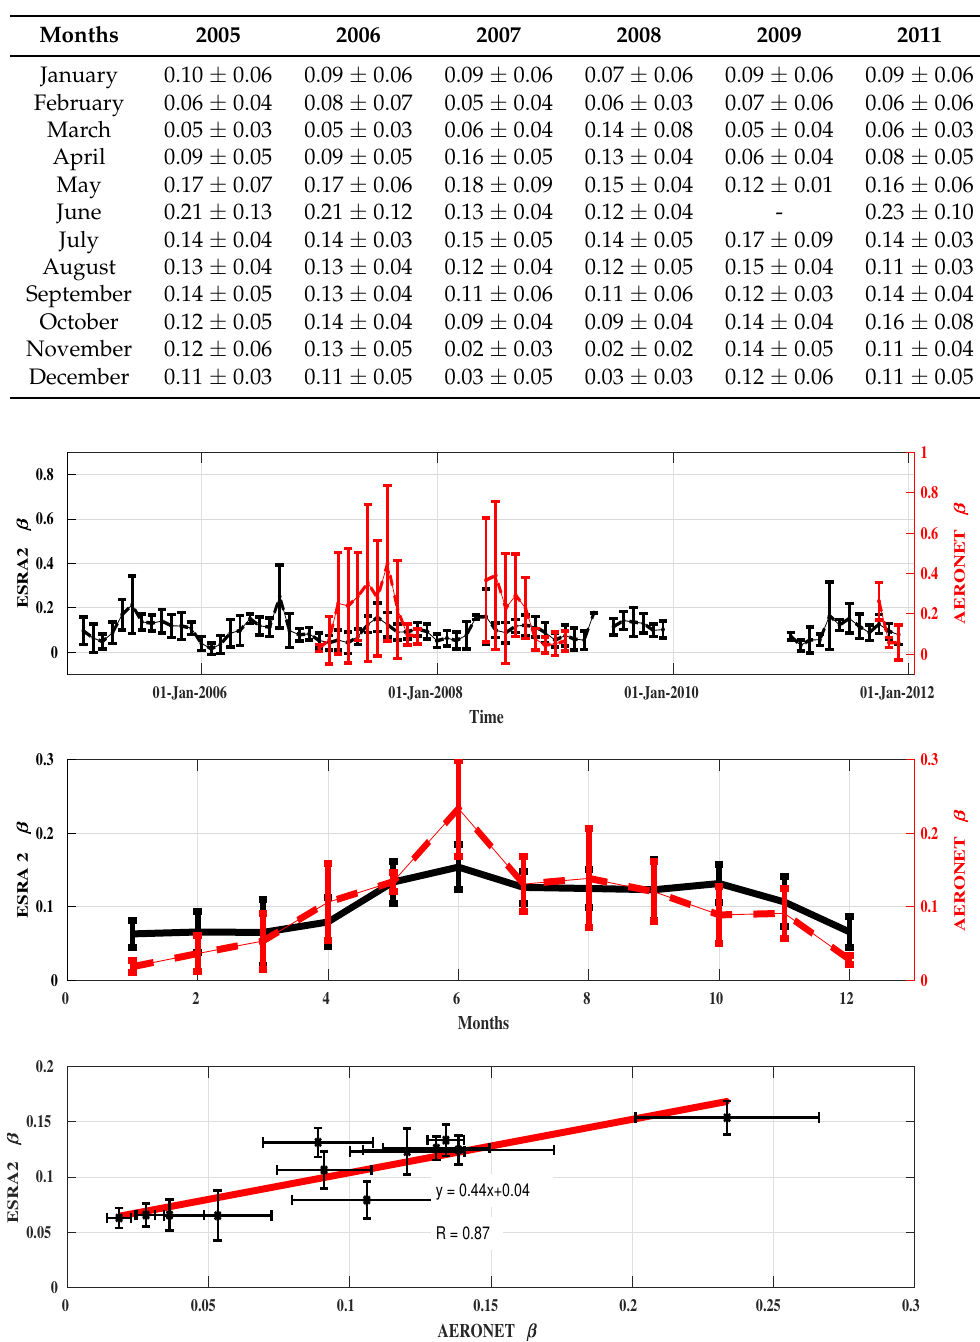
Table 2. Monthly average values of the Angström coefficient.